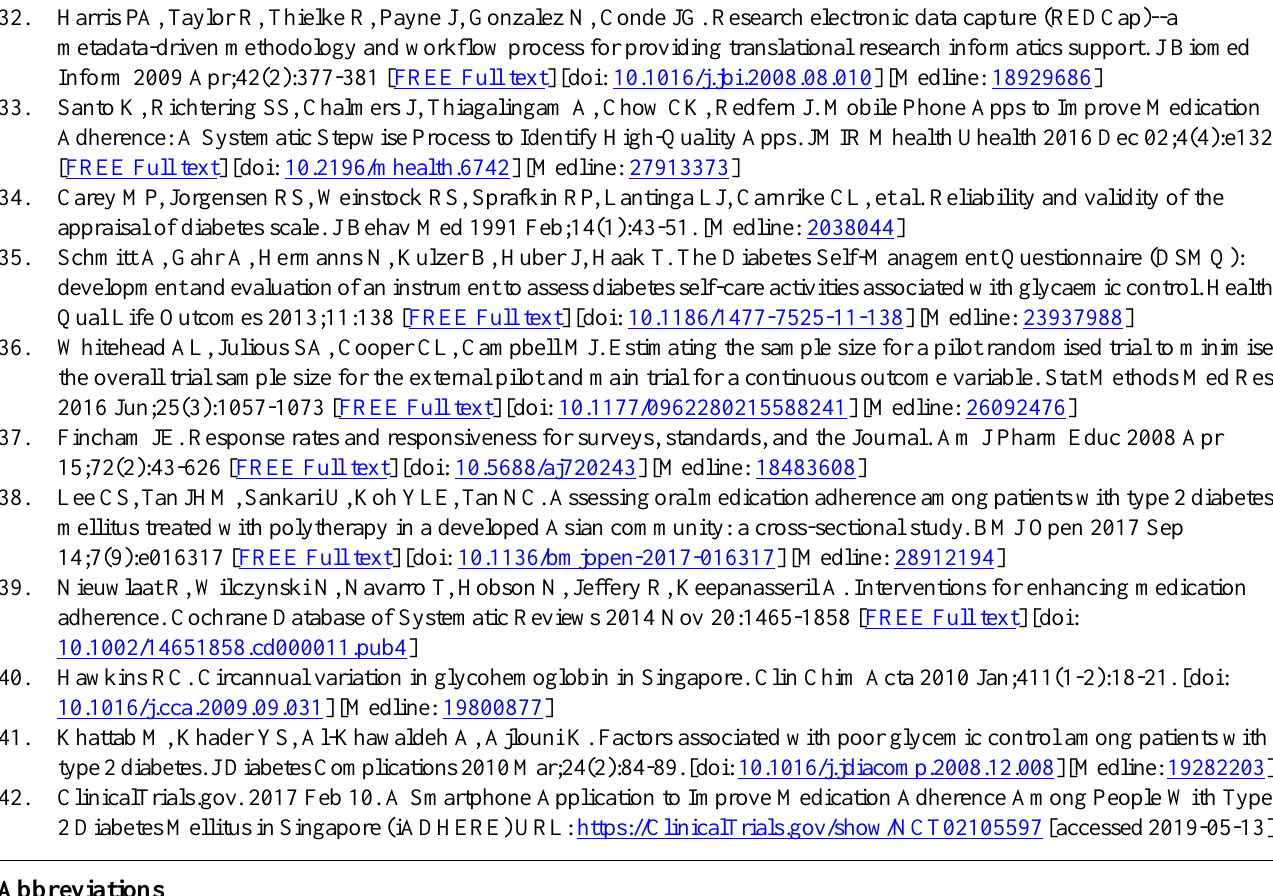
ASK-12: Adherence Starts with Knowledge-12 ADS: Appraisal of Diabetes